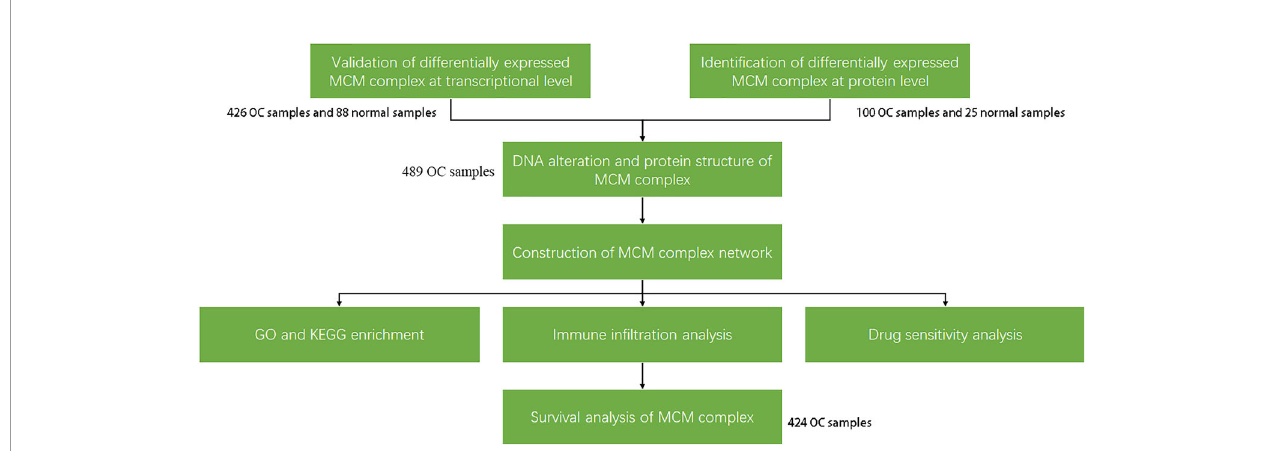
FIGURE 1 | Work fl ow of the study. First, the transcriptional and post-transcriptional levels of the members of the MCM complex were con fi rmed by the Oncomine, GEPIA, UALCAN, CPTAC, and cBioPortal databases (p < 0.05 and |FDR| ≥ 2). There were differences at the transcriptional and post-transcriptional levels among the MCMs. Therefore, the post-transcriptional regulation (miRNA network and protein modi fi cation) among the MCM proteins was con fi rmed by the GSCALite and PDB databases. Then, we constructed the MCM complex network using the GeneMANIA database, which was used to predict GO functions and KEGG pathways. Immune in fi ltration and drug sensitivity analyses of the MCM complex were performed using the TIMER and GSCALite databases. Finally, we con fi rmed the effect of the MCM complex on survival based on the GEPIA